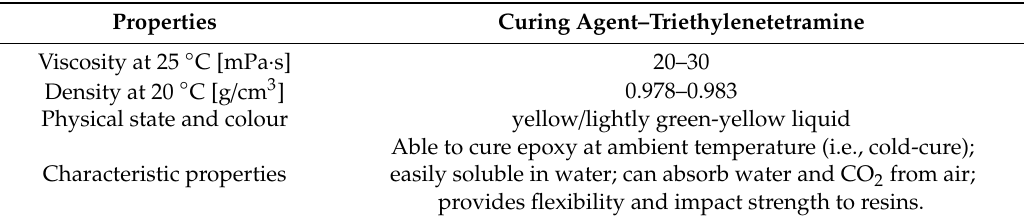
Table 3. Properties of the triethylenetetramine (Z-1) curing